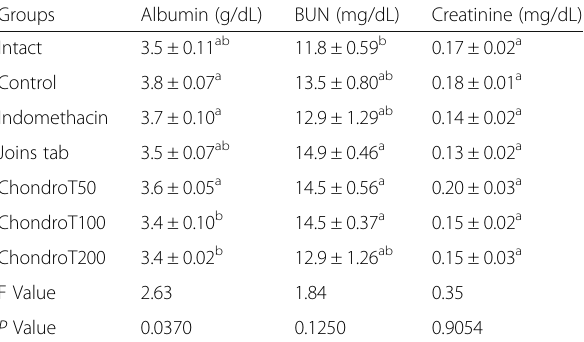
Fig. 7 Changes in serum albumin, BUN, and creatinine content after ChondroT administration in collagenase-induced arthritis rats